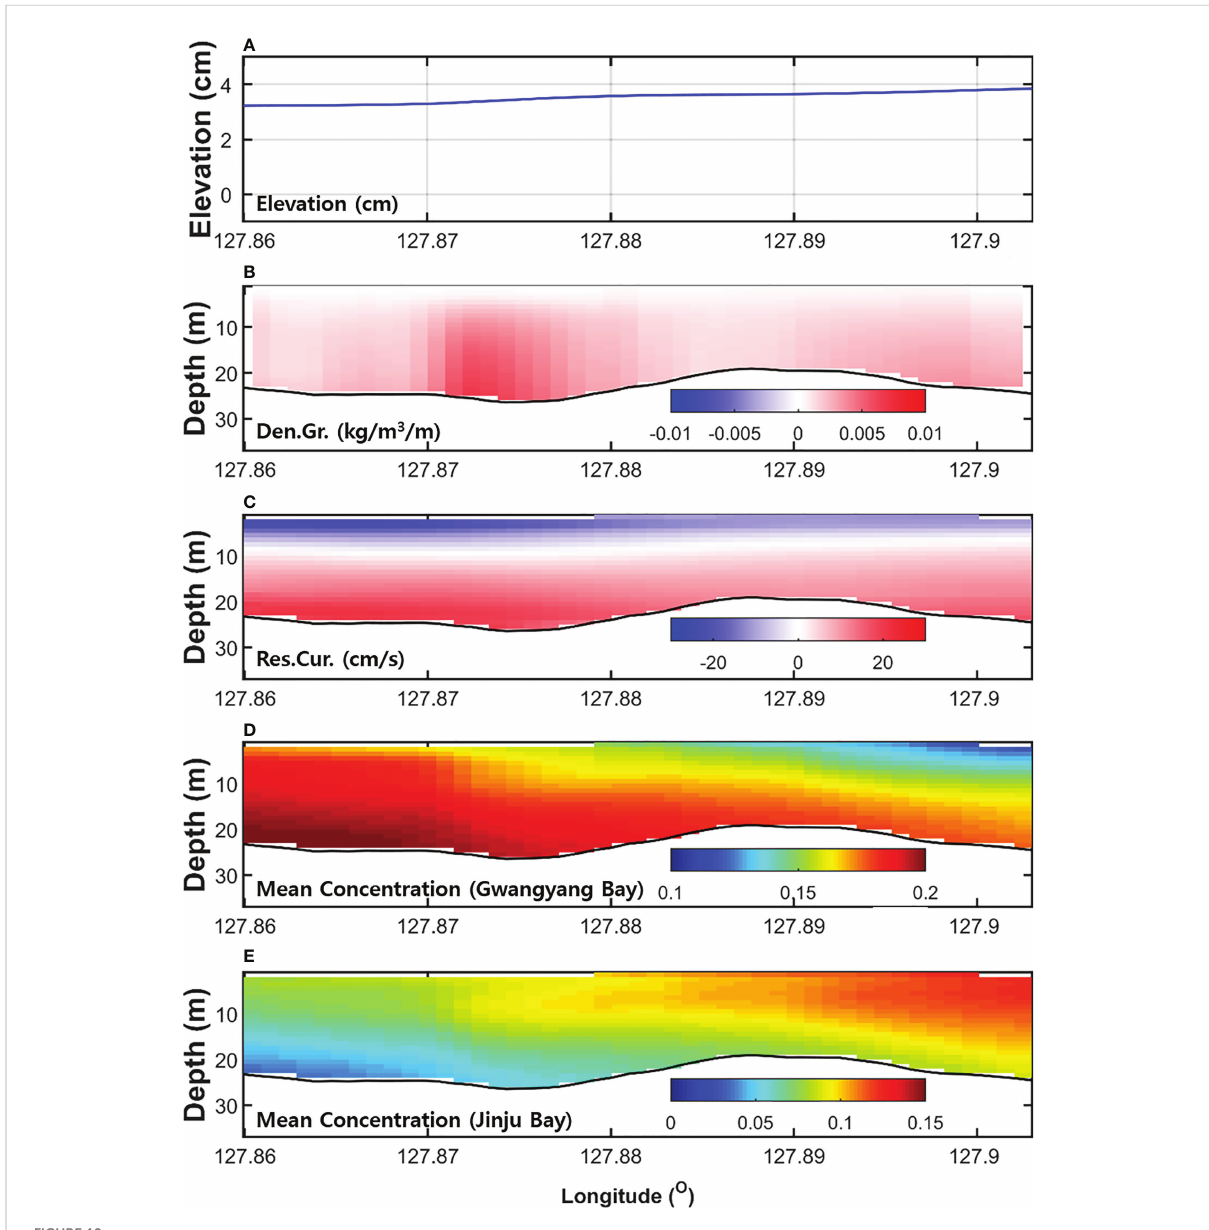
FIGURE 10 Vertical pro fi les of the (A) surface elevation, (B) density gradient, and (C) residual current from the control experiment along the Noryang Channel averaged from 26 June to 24 July. (D) Distribution of dye originating from Gwangyang Bay and (E) distribution of dye originating from Jinju Bay. The positive and negative residual currents represent eastward and westward fl ows,